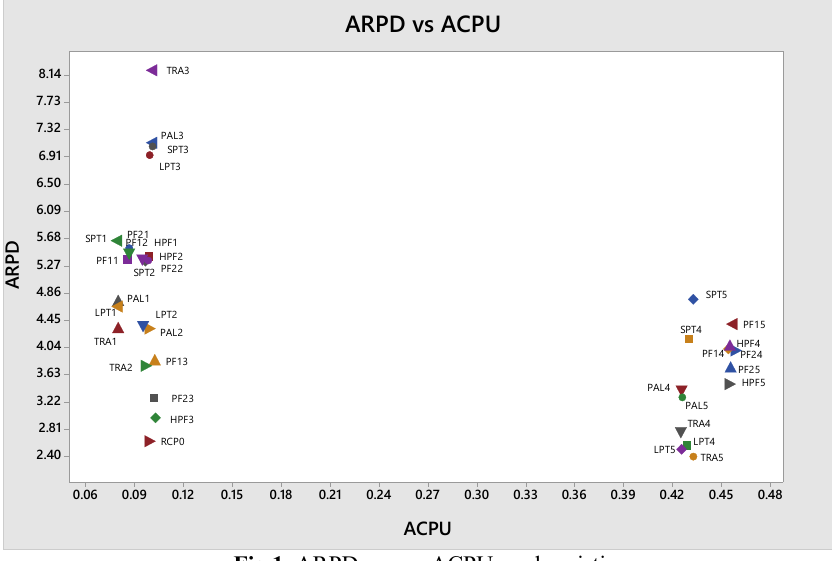
Fig.1. ARPD versus ACPU per heuristic